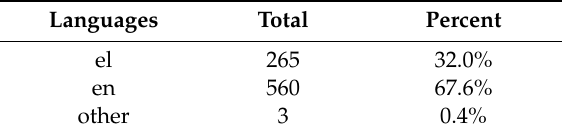
Table A9. Primary languages (cy).